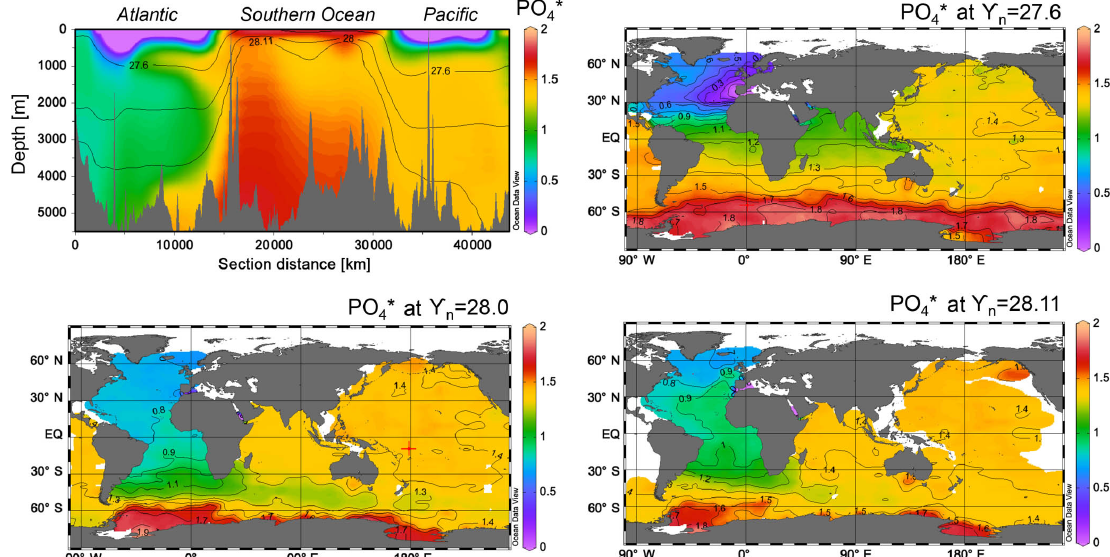
Figure 7. PO ∗ on a section through the Atlantic, Southern, and Pacific oceans and on the 27.6, 28.0, and 28.11 isopycnal horizons. The 4 depths of these horizons are shown in the section. Mixing of low PO ∗ isopycnals, and also diapycnally in the Southern Ocean mixed layer and over rough bottom topography. Data are from GLODAPv2 (Key et al., 2015; Olsen et al., 2016) with profiles, maps, and sections plotted in ODV (Schlitzer,